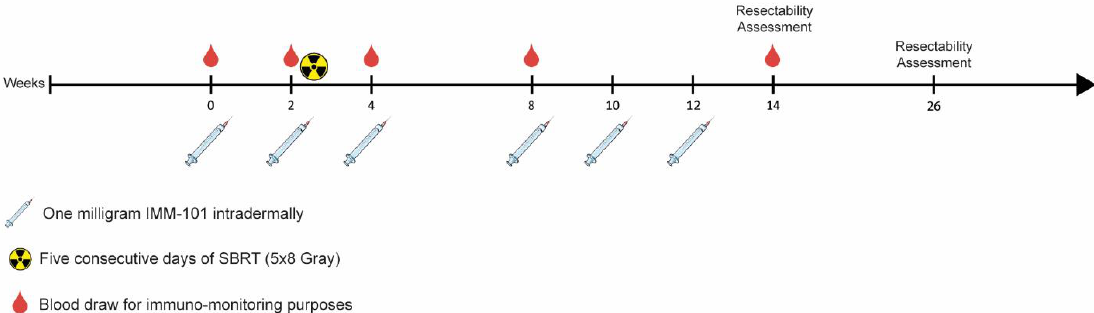
Figure 1. Schematic treatment schedule. After discontinuation of FOLFIRINOX treatment, patients were included in the trial. Patients received three bi-weekly intradermal vaccinations of IMM-101 at weeks 0, 2 and 4. At week 2, after the second vaccination, stereotactic body radiotherapy (SBRT) treatment started. Patients received 5 × 8 Gy of SBRT. They received three more vaccinations at weeks 8, 10 and 12. At week 14, the first resectability assessments was performed. Some patients were offered an explorative laparotomy with possible